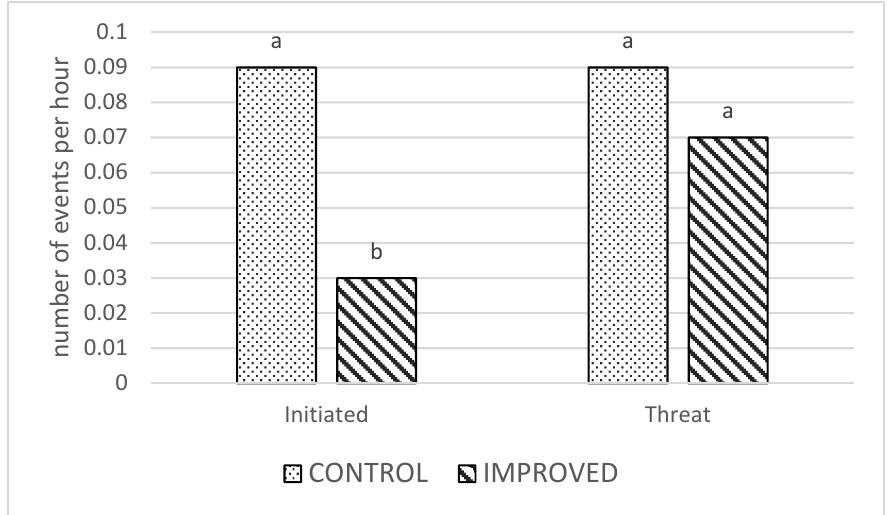
Figure 2. Number of initiated aggressive behaviors and threats per hour in the CONTROL and IM- PROVED pens. a, b: Different letters indicates significant differences ( p < 0.05) between treatments.